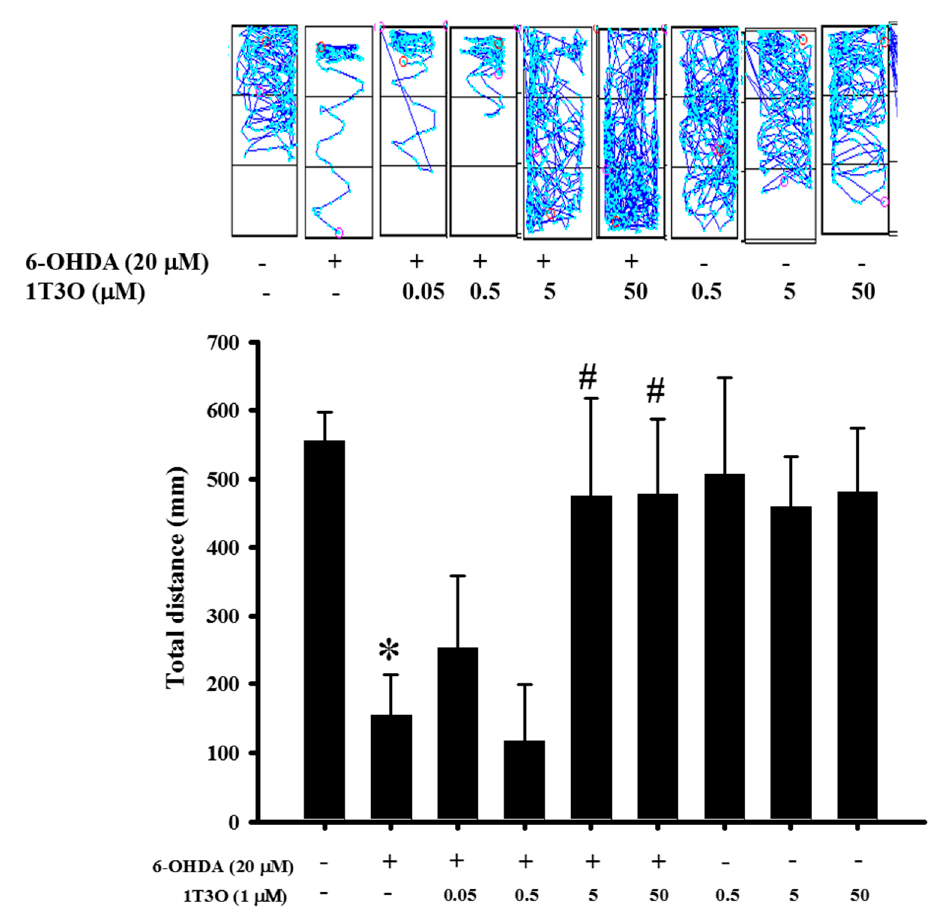
Figure 10. Effect of 1T3O on 6-OHDA-induced deficits in locomotor activity of zebrafish. The figure represents the effect of 1T3O on 6-OHDA-induced deficits in zebrafish locomotor activity. Results show that 1T3O can effectively ameliorate 6-OHDA-induced deficits in zebrafish locomotor activity. Data are presented as mean ± SEM. Total number of animals = 12; * p < 0.05 vs. Control group without any treatment; # p < 0.05 vs. 6-OHDA-only group.